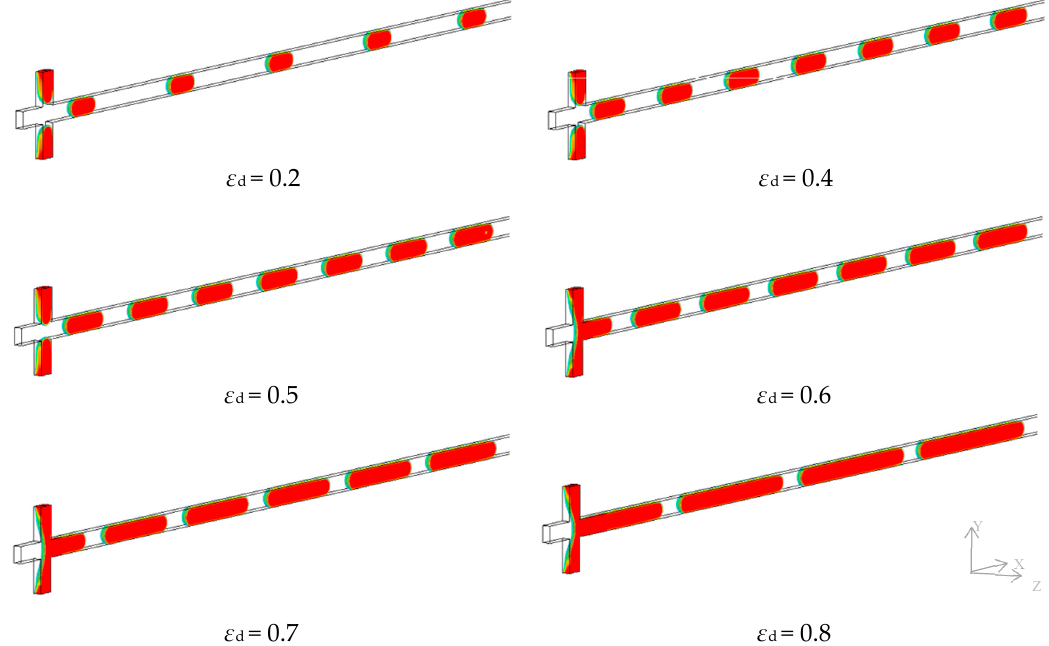
Figure 3. Droplet formation process in three junction configurations. u total = 50 mm/s, ε d = 0.5. ( a ) Droplet formation process in the cross-shaped junction; ( b ) Droplet formation process in the cross- shaped T-junction; ( c ) Droplet formation process in the T-junction.